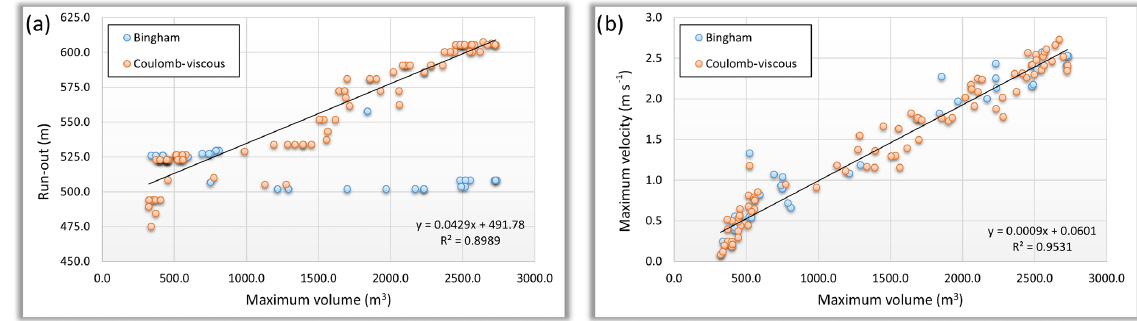
Figure 7. Correlation between the maximum volume and (a) the run-out and (b) the maximum flow velocity, for DF#1.